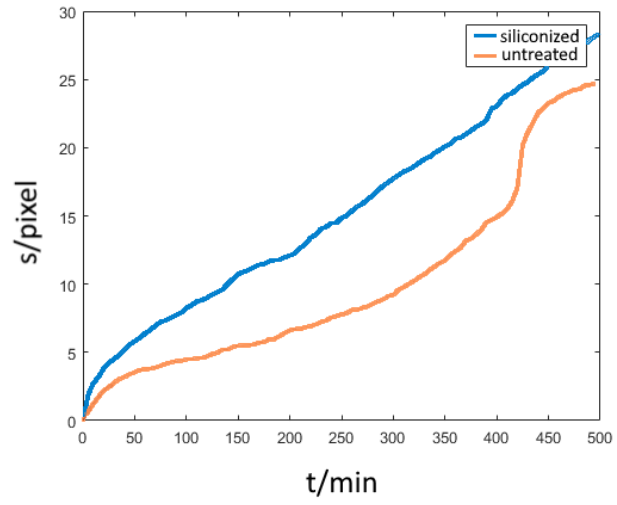
Figure 13. Influence of surface treatment on interface diffusion using a thin PDMS film. The adhesive bond between Sylgard-184 and the siliconized copper is weaker, thus leading to faster corrosion-triggered delamination reflected in the more pronounced linear behaviour. Furthermore, the shallower and thinner edge accelerates the diffusion in the starting